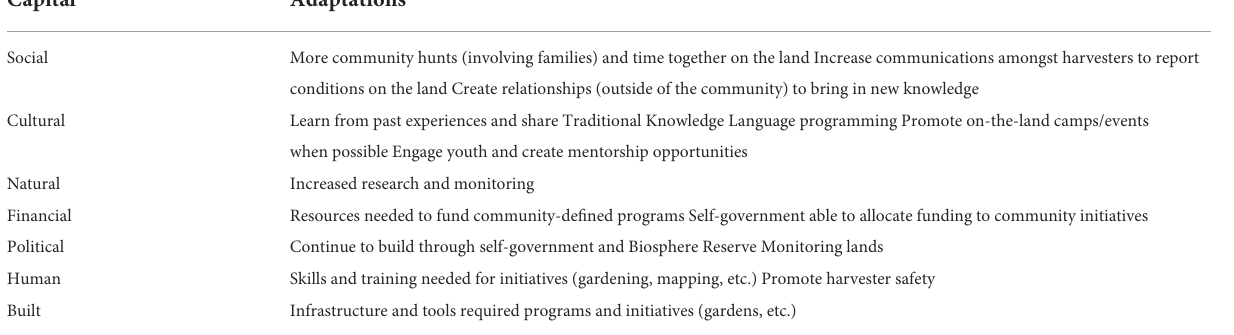
TABLE 2 Community capitals required to build a sustainable food system in Délı˛ne˛. Capital